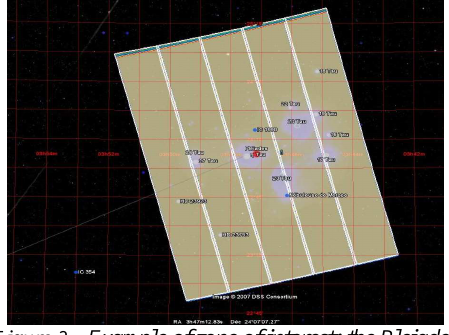
Figure 3 : Example of zone of interest: the Pleiades constellation